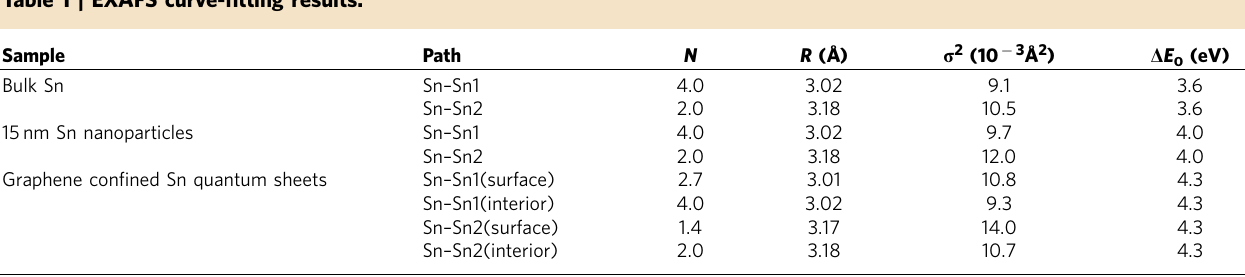
Table 1 | EXAFS curve-fitting results.